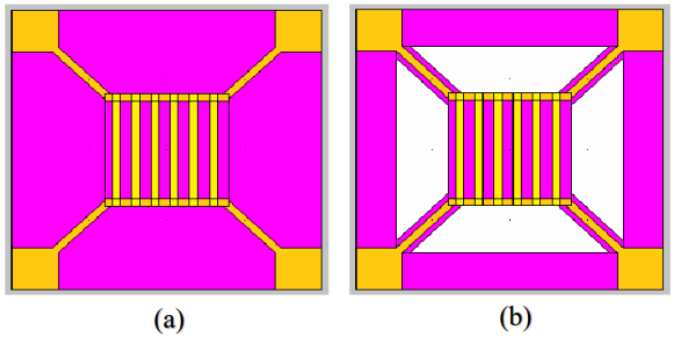
Figure 22. Top view of micro hot plate structure ( a ) Diaphragm type; ( b ) Cantilever type